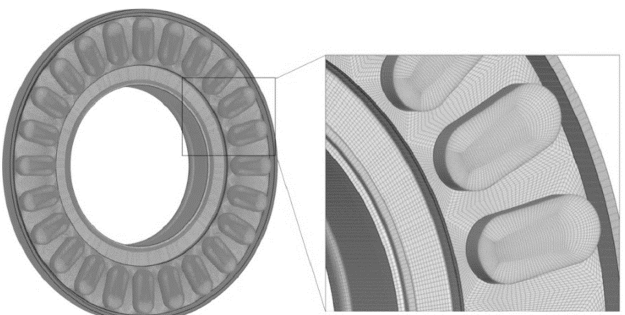
Figure 7. Grid of computation domains.